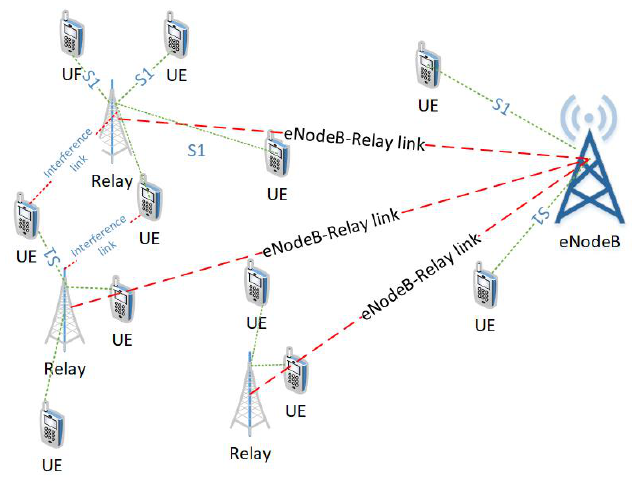
Figure 7. LTE-A Network with Multiple L3 Relays.